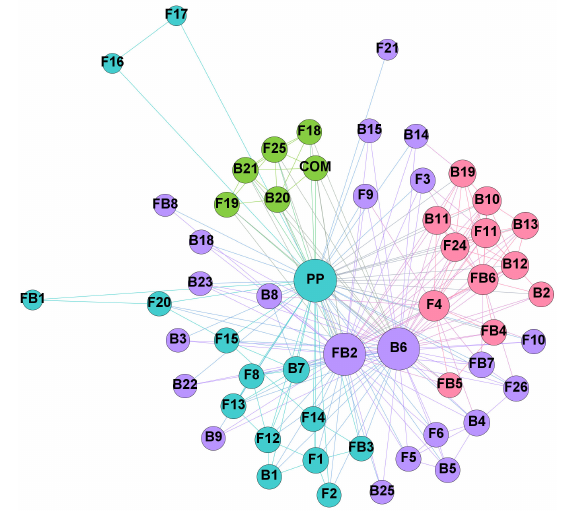
Fig. 6 . The social-ecological network of smallholders where color indicated community membership and size indicates centrality. The pour point (PP) is the outlet of the